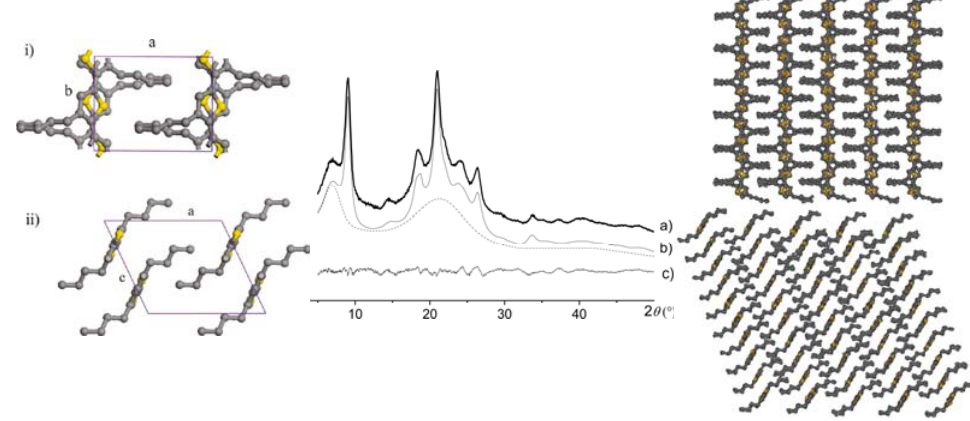
Fig. 3. Results for form II of P3BT. On the left, we show two views of its P2 1 /c unit cell (lattice parameters: a =10.76 Å, b =7.77 Å, c =9.44 Å, (cid:533) =64.66°). In the centre, we show a comparison of the experimental and calculated WAXS profiles. On the right, we show two snapshot from a room-temperature MD